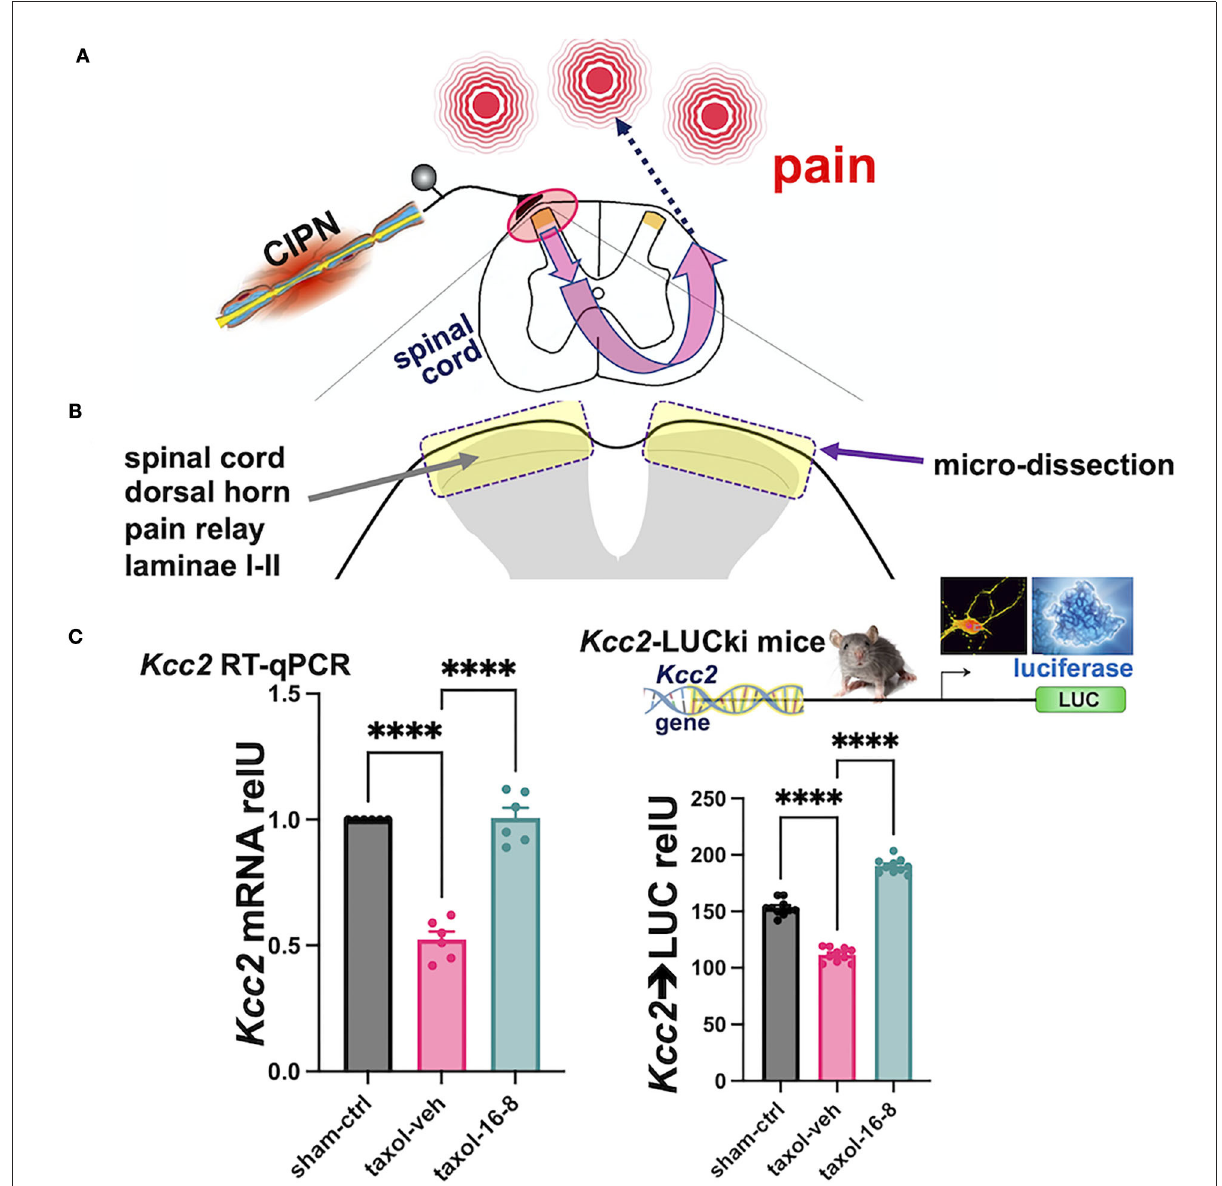
FIGURE2 Topical treatment with compound 16-8 repairs damage of the sensory gate function of the spinal cord dorsal horn inflicted by Taxol. (A) Shows a schematic representation of the experimental paradigm. Peripheral nerve damage by neurotoxic impact of Taxol sensitizes a central pain circuit, a paradigm widely implemented in preclinical mouse models of human chemotherapy-induced painful peripheral neuropathy (CIPN). (B) Shows a schematic representation of our experimental focus on the SCDH and our sampling strategy. SCDH tissue, superficial layers I-II were microdissected as in Yeo et al. (2021), then processed for measurements of Kcc2 gene expression, as assed by metrics of mRNA abundance of Kcc2 and Kcc2 promoter activity. (C) These bar diagrams show our results of measuring Kcc2 gene expression. (Left) This bar diagram shows reduced abundance of Kcc2 mRNA, as measured by RT-qPCR, in response to Taxol. Note significantly reduced levels of Kcc2 mRNA in formulation vehicle-treated mice (purple) vs. sham (instead of Taxol)-treated mice (black). In compound 16-8-treated mice, notice renormalization of Kcc2 expression back to sham (instead of Taxol) levels (green). n = 6 mice per group, bars represent mean + SEM, **** p < 0.0001, 1-way ANOVA with post-hoc Tukey’s test. (Right) This bar diagram shows results derived from Kcc2 -LUCki mice, see Methods, for measurements of Kcc2 promoter activity. Similar to the left-hand panel (same color scheme), activity of the Kcc2 promoter is significantly reduced when subjecting mice to Taxol, which is renormalized to normal levels in compound 16-8-treated mice. n = 10 mice per group, bars represent mean + SEM, **** p < 0.0001, 1-way ANOVA with post-hoc Tukey’s